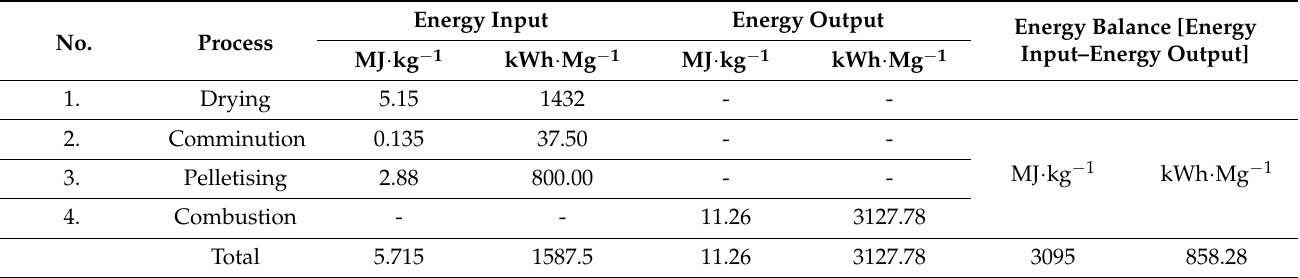
Table 12. The energy balance of the combustion of Silphium perfoliatum